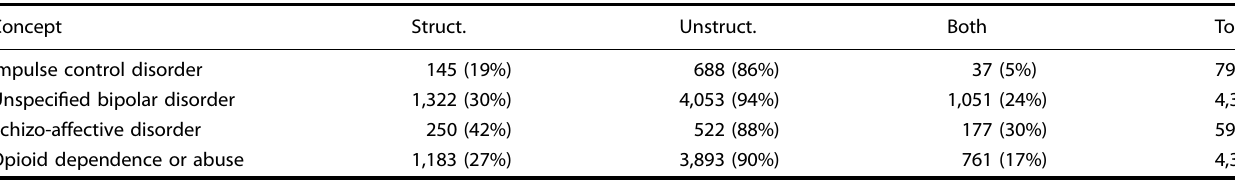
Fig. 3 Distribution of time between penultimate hospital visit and fi rst suicide attempt, in days. As the distribution was highly skewed, the x -axis was capped at 100 days for clarity. A few patients had several years between their last recorded visit and suicide attempt. Table 1. Correspondence between structured and unstructured codes.